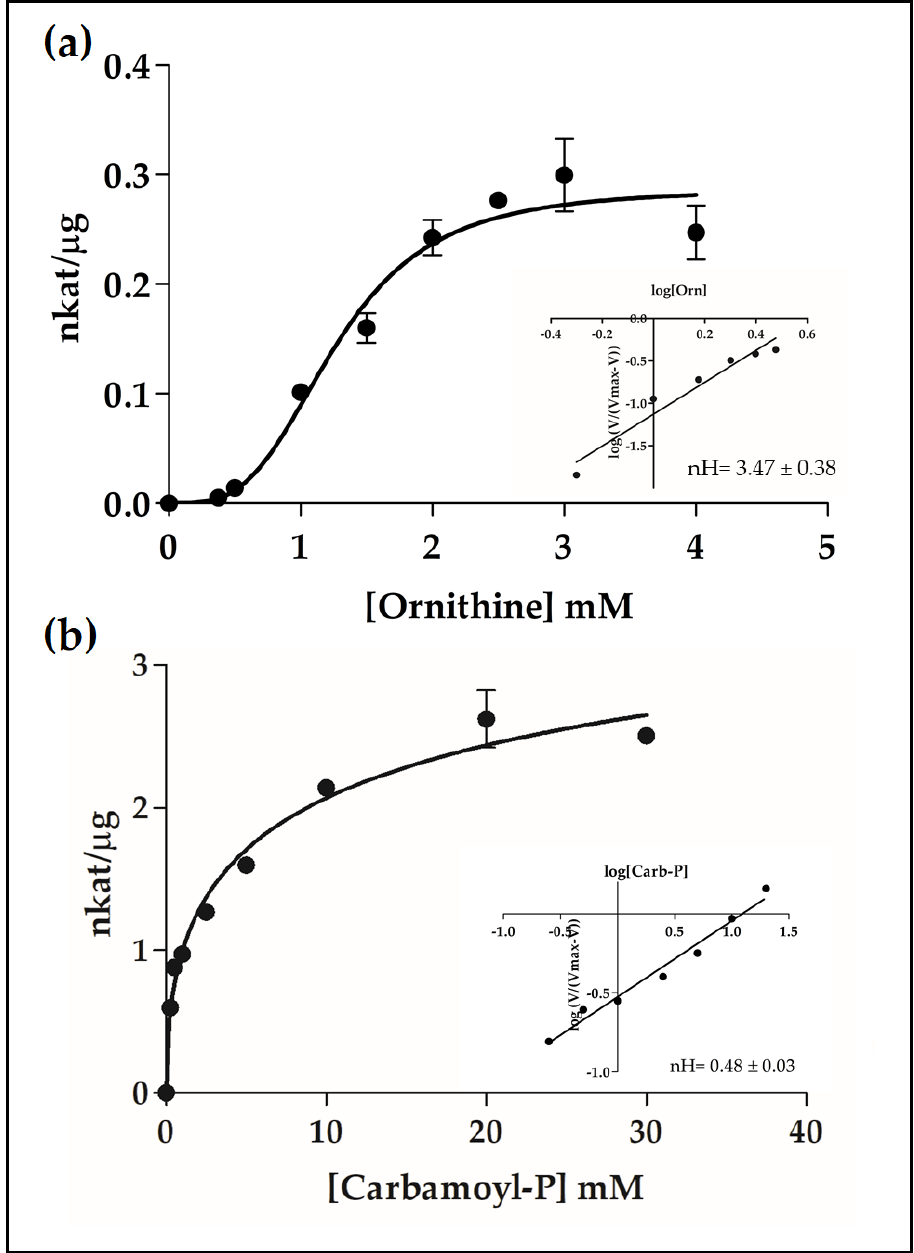
Figure 4. Sigmoidal kinetics of PpOTC. The graph shows the saturation curve of the enzyme in the presence of ornithine ( a ) and carbamoyl-P ( b ). A Hill plot of the kinetic data is shown in the inset (nH = 3.47 ± 0.38 for ornithine; nH = 0.48 ± 0.03 for carbamoyl-P).